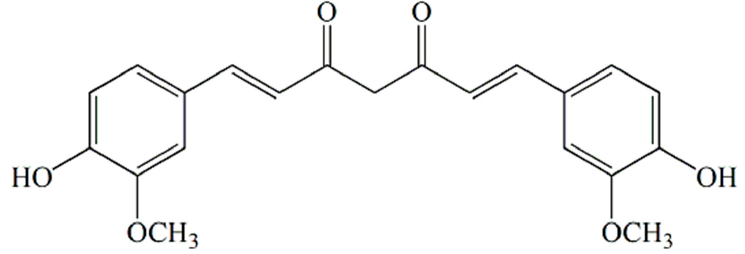
Figure 1. Chemical structure of curcumin.